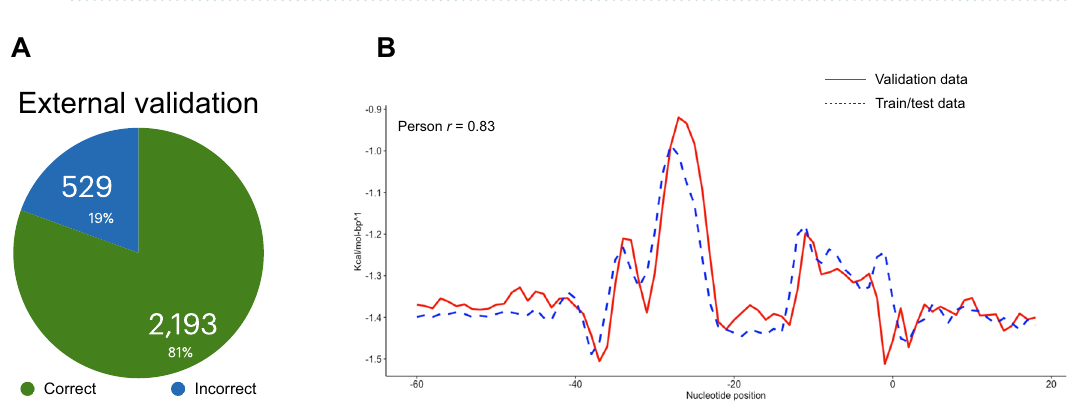
Figure 2. Model validation with external data. In ( A ), we show the rate of our SVM model in assigning the TRUE label to 2719 experimentally validated promoter sequences of the archaeon Thermococcus kodakarensis . The sequences are available in the Prokaryotic Promoter Database. In ( B ), we demonstrate the DNA Duplex Stability profile of the 3935 promoter sequences used to train/test the model (dashed blue line) against the 2719 external sequences (continuous red line). The two promoter datasets showed a strong level of correlation ( r =